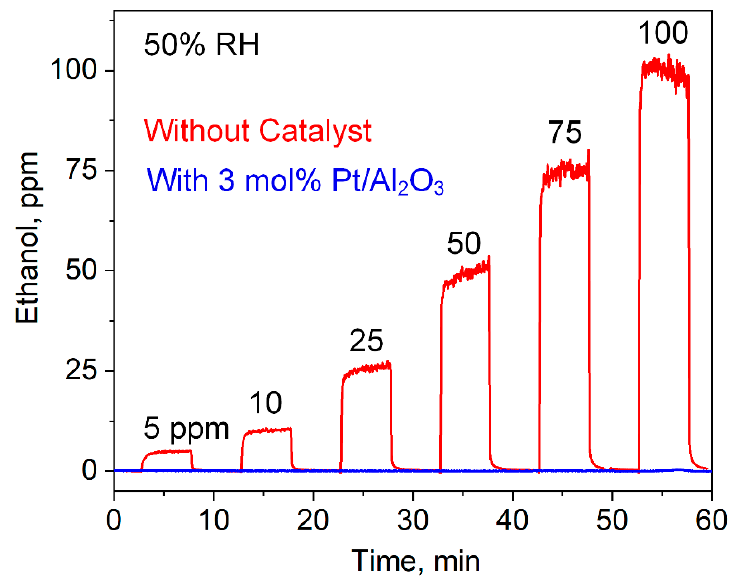
Figure 4. Exposure to 5–100 ppm ethanol, as detected by the PTR-ToF-MS without (red) and with (blue) the 3 mol% Pt/Al 2 O 3 filter at 40 °C. Note that 50% RH is used instead of 90% due to a limitation of the measurement setup at such high analyte concentrations.